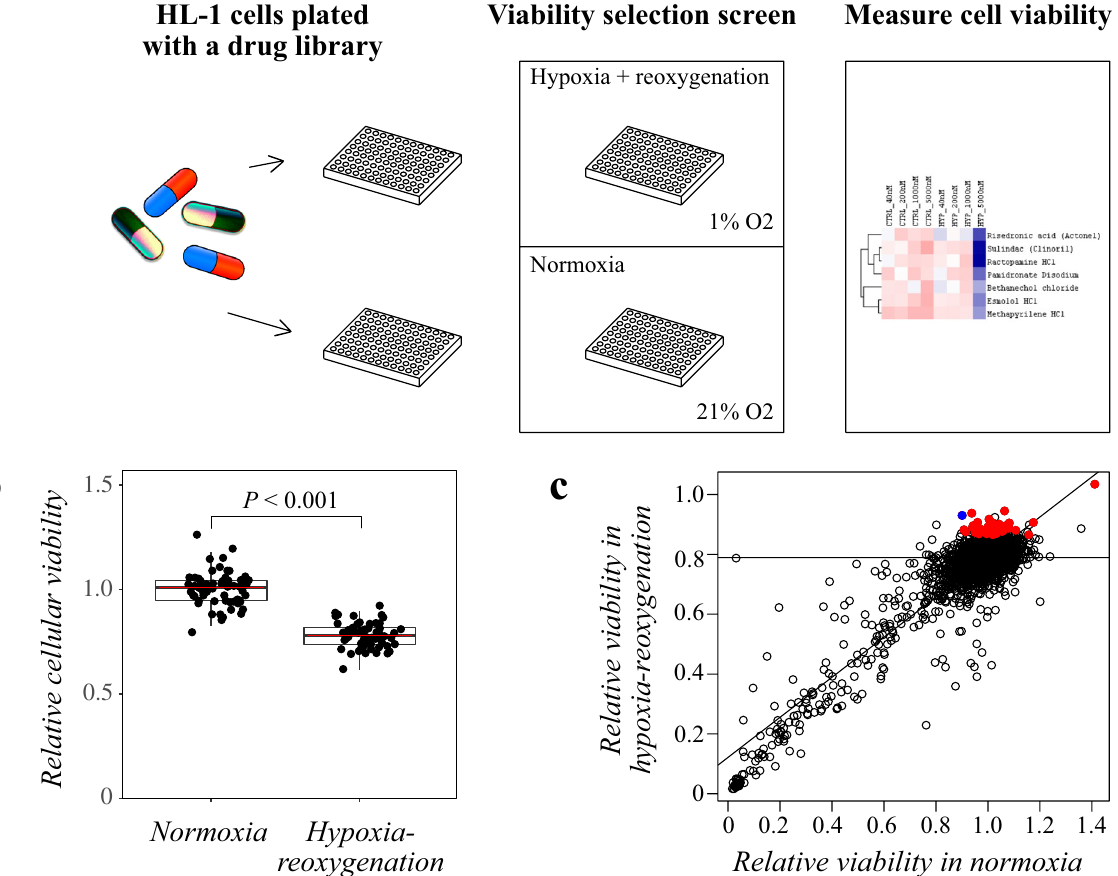
Figure 2. Drug library screening to identify compounds affecting cardiomyocyte viability. Schematic overview of the drug library screen. HL-1 cells were plated with a drug library consisting of 689 FDA-approved compounds. Cells were exposed to hypoxia-reoxygenation for a viability dropout screen. As the readout, cellular viability was measured with CTG assays. ( b ) Effect of hypoxia-reoxygenation on the viability of DMSO-treated control cells (22% reduction in relative viability ( P < 0.001)). ( c ) Scatter plot of DMSO-normalized relative viability values in normoxia vs. hypoxia-reoxygenation for each drug concentration. Correlation curve depicts the linear model of the correlation of the values between treatments. Horizontal line depicts the average viability of DMSO-treated cells in hypoxia-reoxygenation. Significant viability-improving effects are depicted with red dots for the maximally effective drug concentrations. The dot representing gefitinib is indicated in